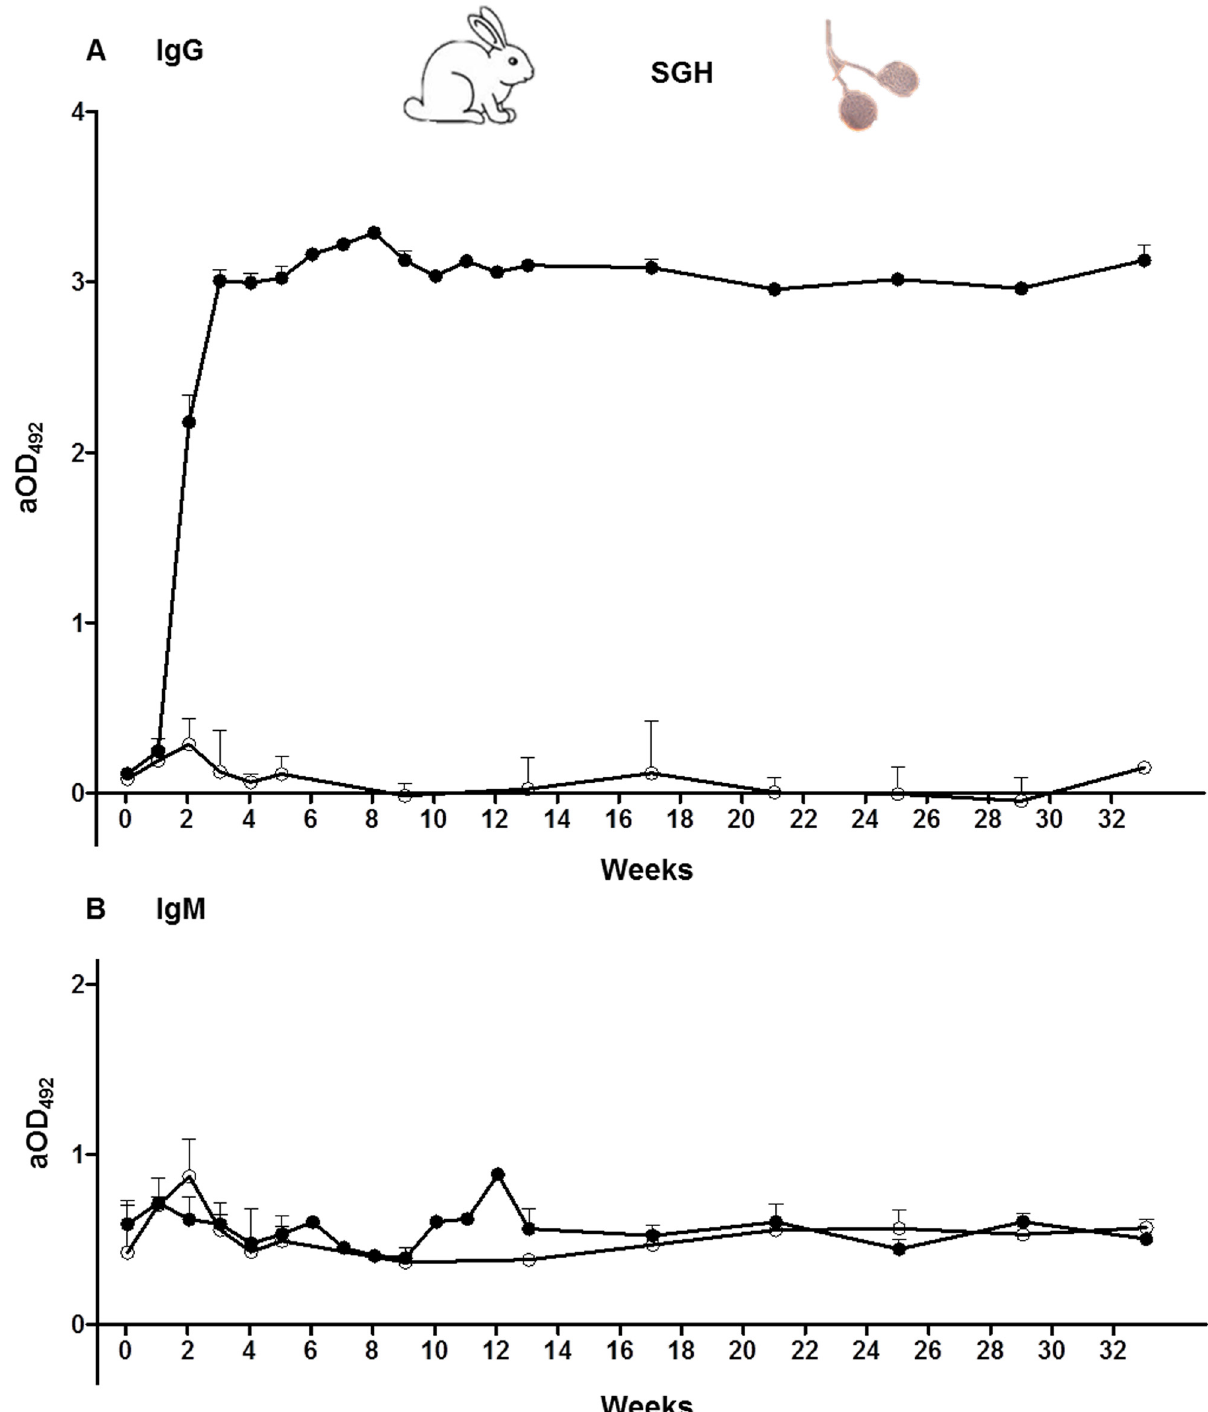
Fig 4. Humoral responses against salivary gland homogenate detected in sera of rabbits. (A) IgG antibody levels. ( B) IgM antibody levels. Open circles symbolize the non-exposed rabbit group while closed circles indicate the immunized rabbit groups (Rabbits 1 – 4). Bars represent the geometric means. Antibody levels are expressed as adjusted optical density measured at 492 nm (aOD 492 ).